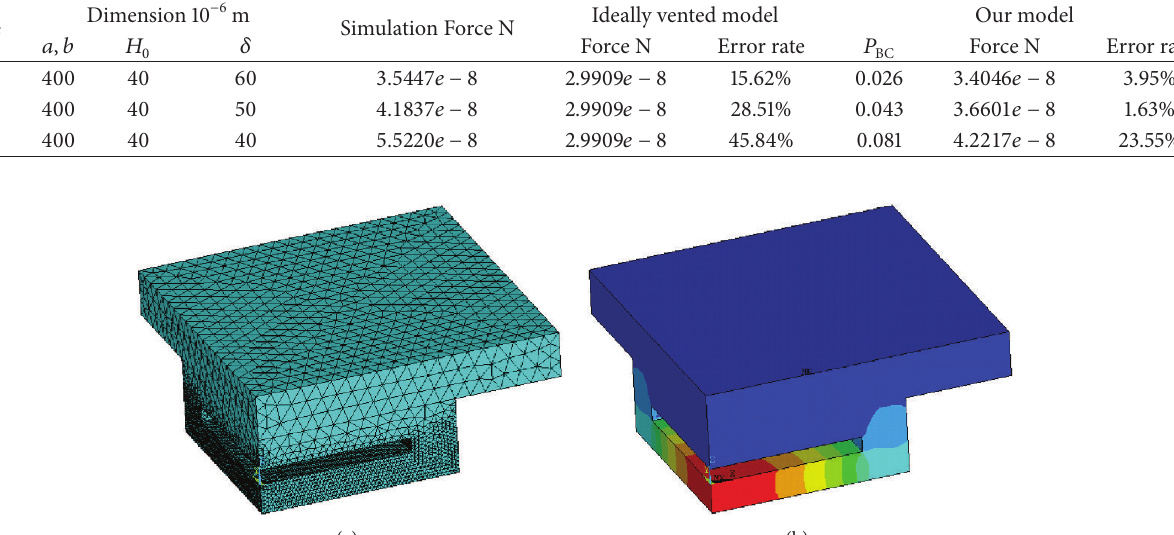
Figure 3: Simulated results in a constant velocity normal moving rectangular movable plate. (a) Typical mesh and (b) pressure distribution.